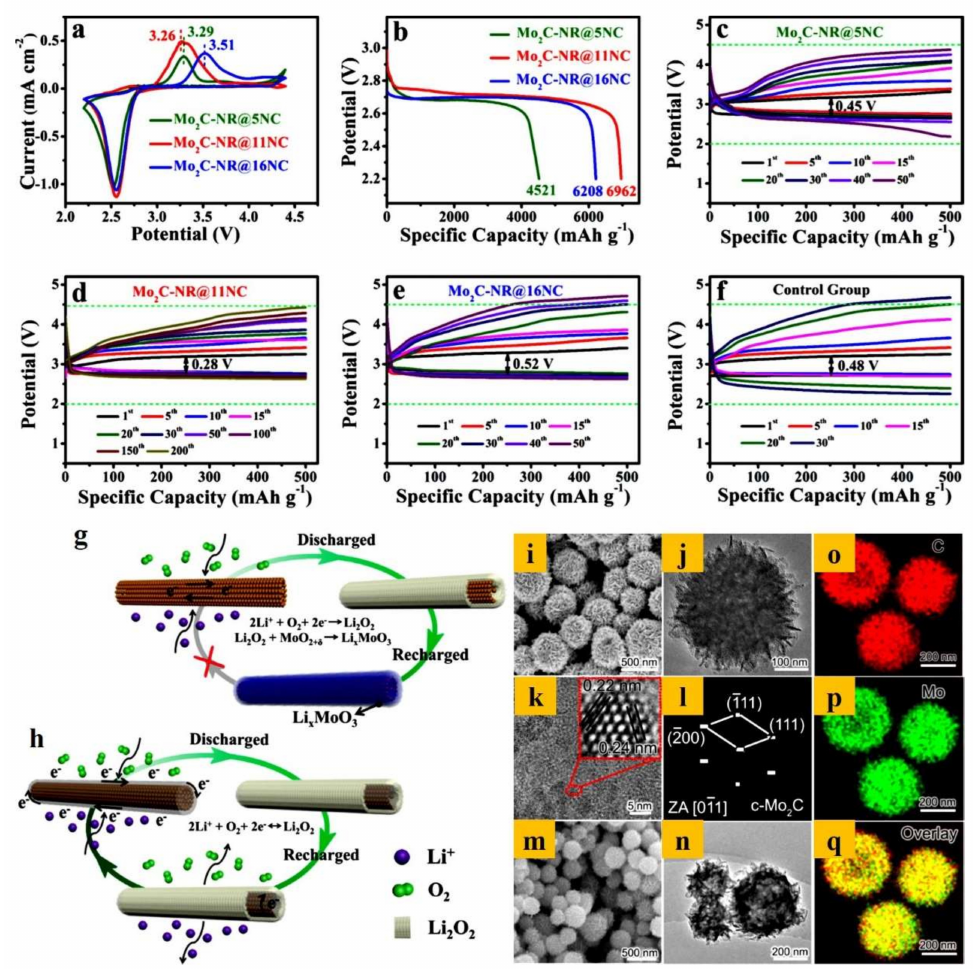
Figure 10. ( a ) CV plot of NC-doped Mo 2 C-NR (Mo 2 C-NR@xNC; x = 5, 11, and 16%) for an LOB under an O 2 atmosphere at 0.1 mVs − 1 . ( b ) GCD plot of Mo 2 C-NR@xNC (x = 5, 11, and 16%) at 100 mA g − 1 . ( c ) Discharge profile for an LOB with Mo 2 C-NR@5%NC. ( d ) Discharge profile of an LOB with Mo 2 C-NR@11%NC. ( e ) Discharge profile of an LOB with Mo 2 C-NR@16%NC. ( f ) Discharge plot of the control group at 100 mA g − 1 . ( g , h ) Graphical representation of an LOB cell with Mo 2 C-NR